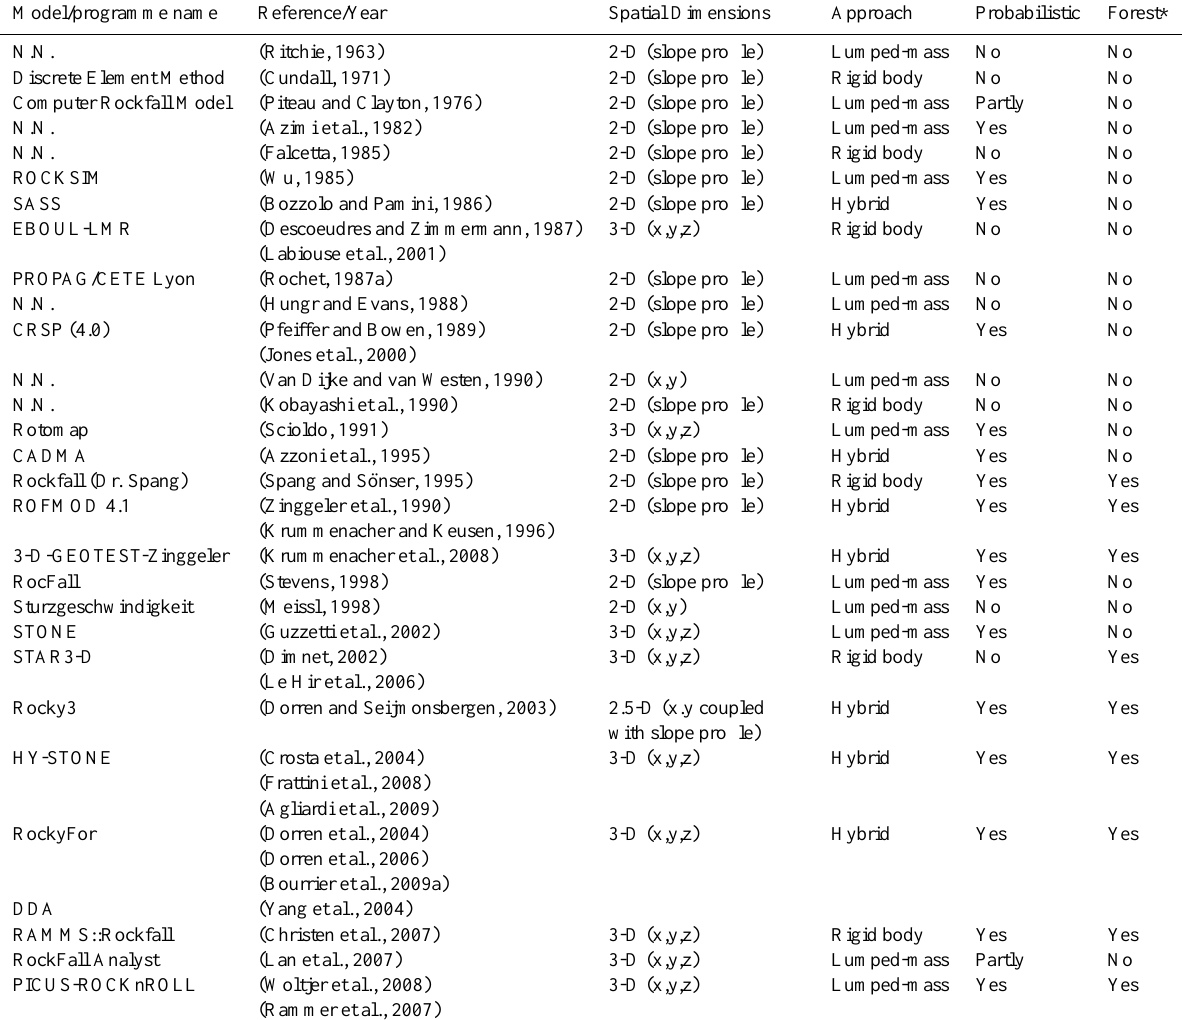
Table 1. Main characteristics of a selection of existing rockfall trajectory models (modified from Guzzetti et al.,